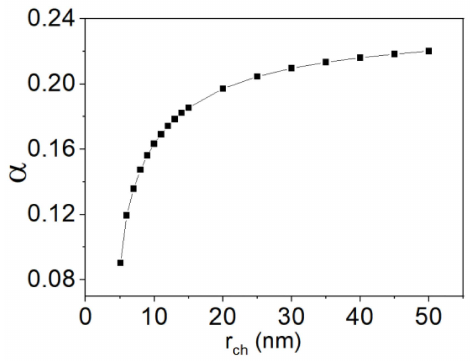
Figure 3. Plot of α (in Equation (3) for SS) vs. r ch , when both t ox and t ch is 5 nm. Note that α is significantly decreased if r ch is 15 nm or shorter.